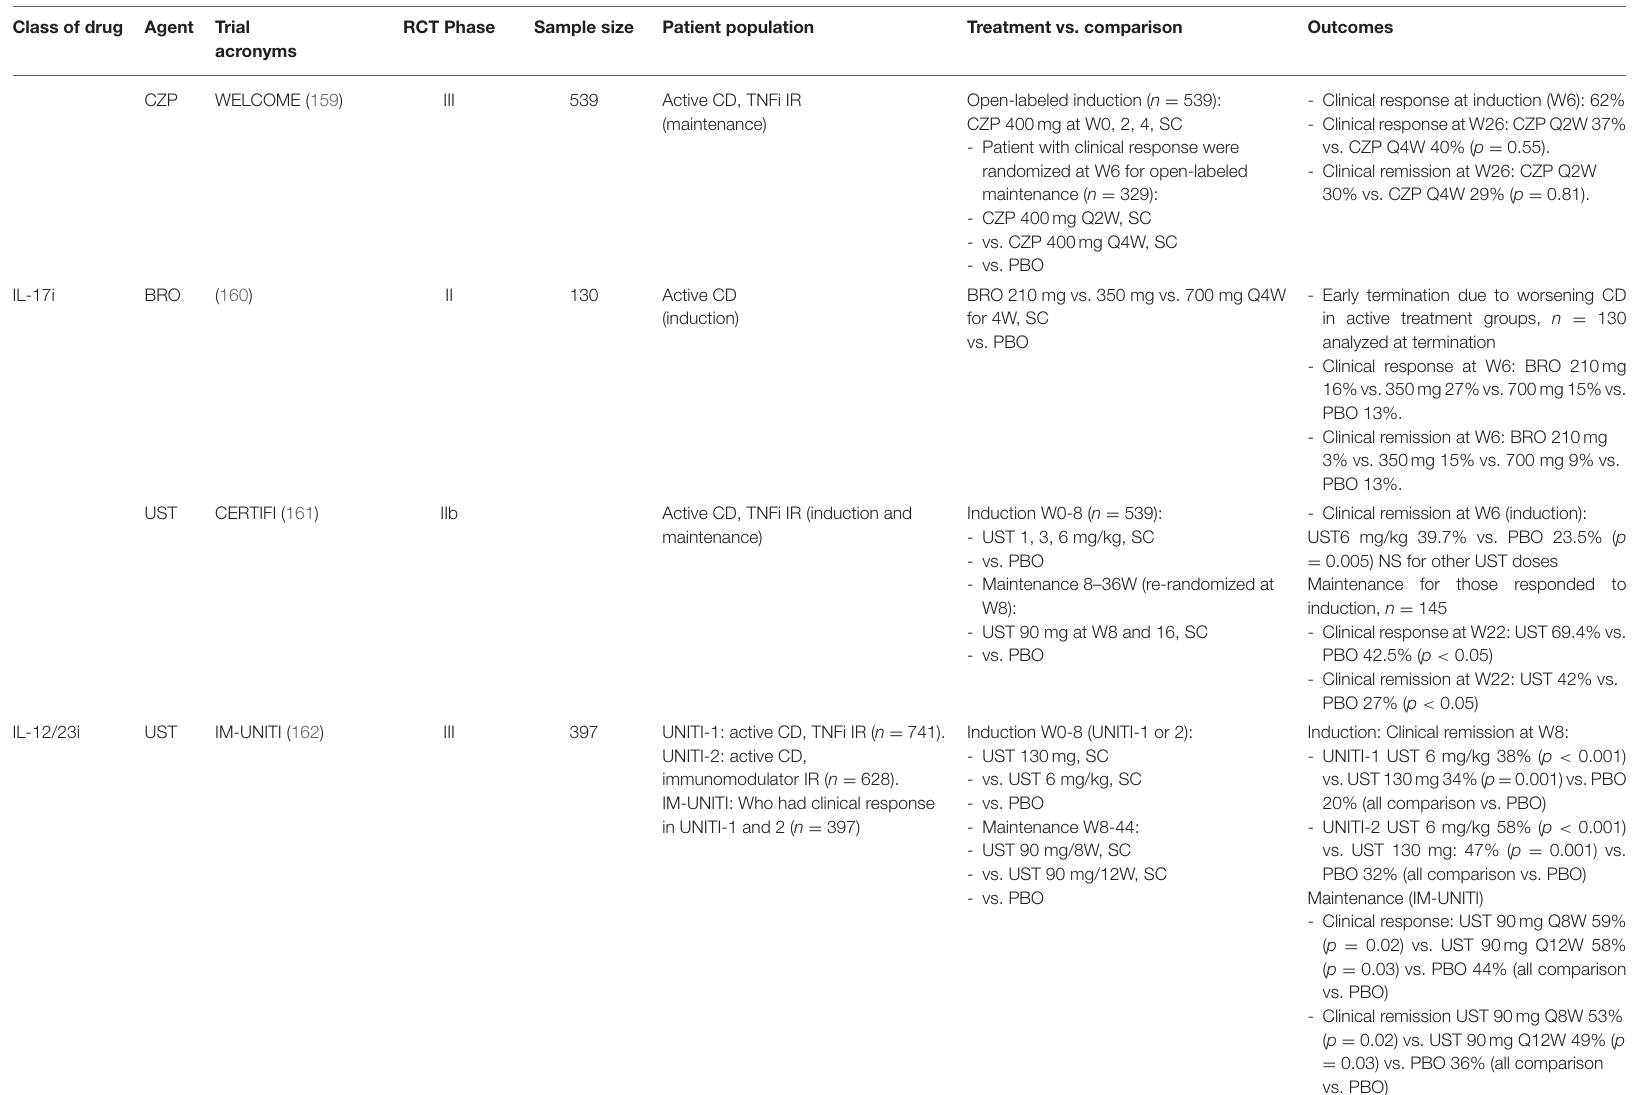
Class of drug Agent Trial